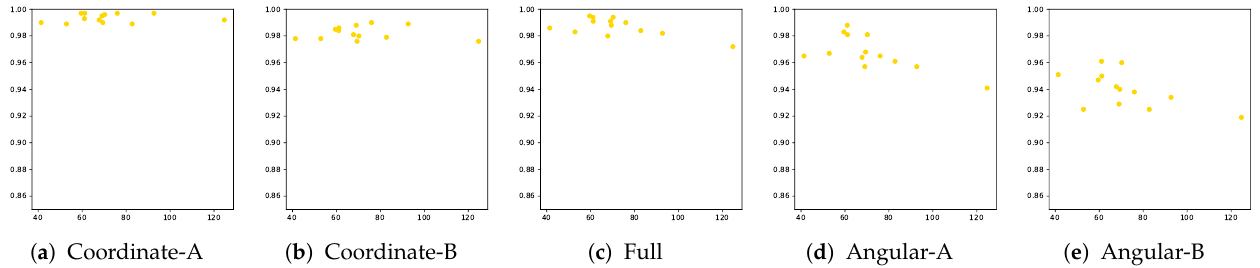
Figure 11. Average AUROC according to sequence length for each variable combination set by TCN (x-axis: sequence length, y-axis: AUROC).